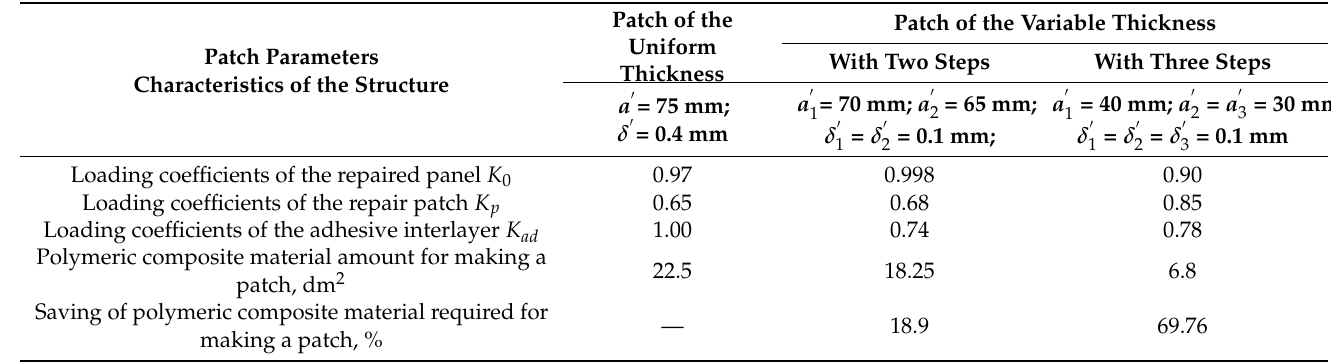
Table 4. Rational geometric parameters of the repair patches satisfying the criteria of operability of the repaired structure and the condition for the minimum mass. Patch of Patch Parameters Characteristics of the Structure